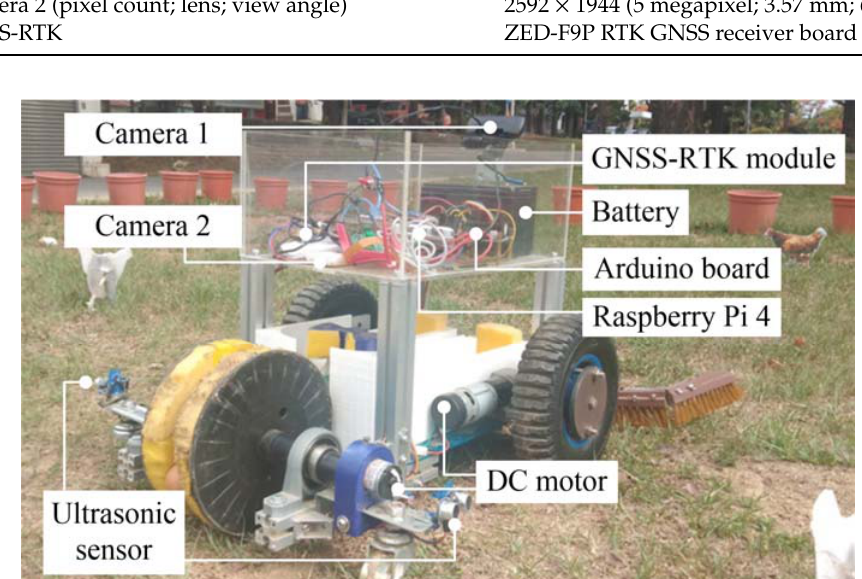
Figure 7. The appearance of the proposed robot.